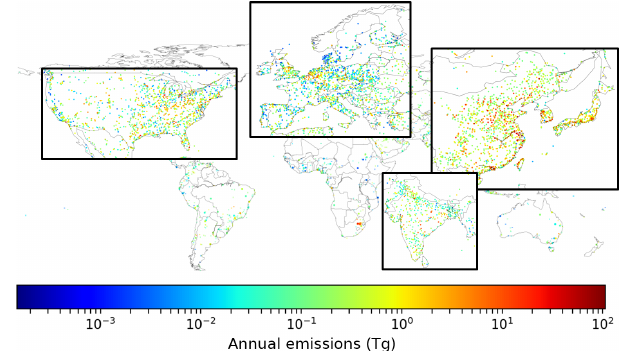
Figure 5. The spatial distribution of emission-weighted centers of the emission clumps all over the globe. The inserted plots zoom into four regions that contain most of the